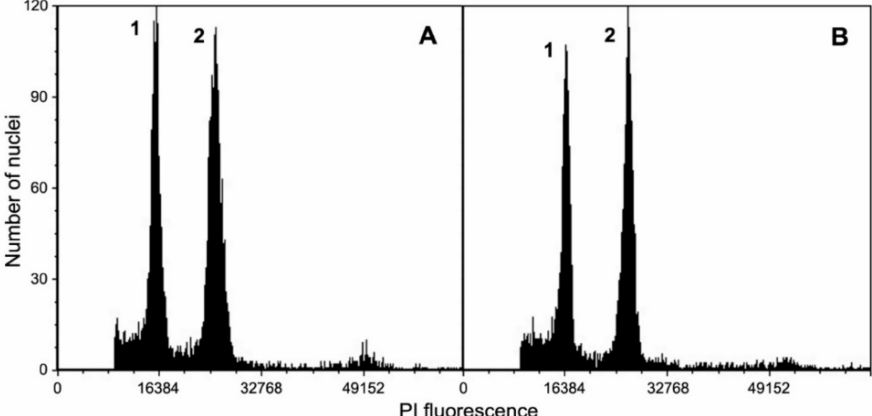
Figure 2. Histograms of the nuclear DNA content obtained after the flow cytometric analysis of the PI-stained nuclei isolated simultaneously from leaves of Linnaea borealis var. borealis (peak 1), seedling ( A ) and a micropropagated plant ( B ), and Petunia hybrida (the internal standard; peak 2).